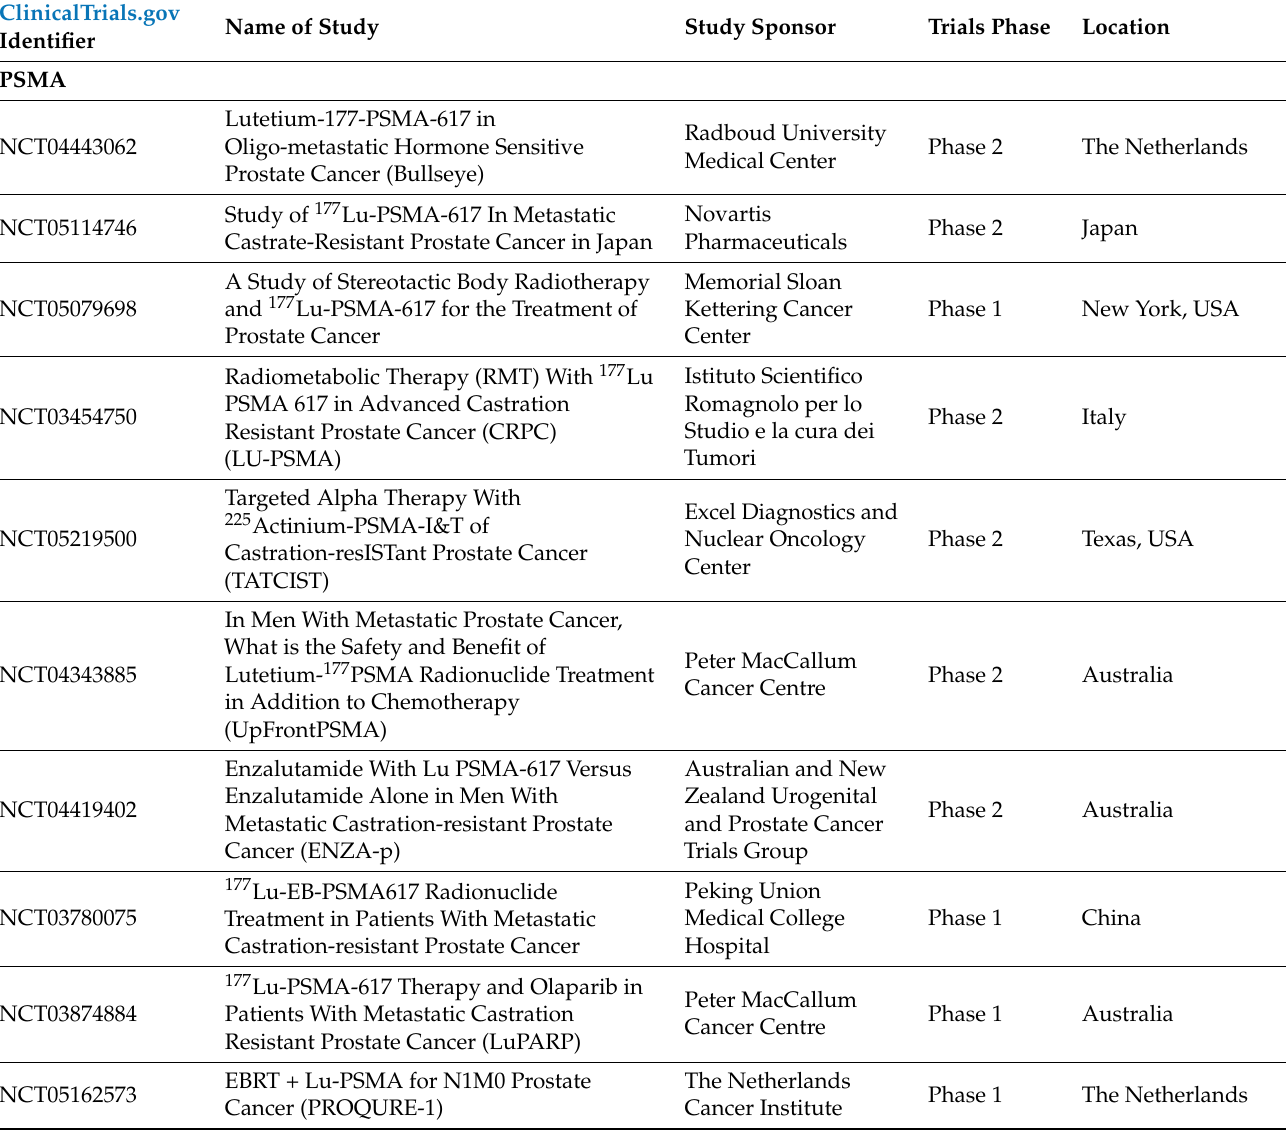
Table 2. Current ongoing targeted radionuclide clinical trials for prostate cancer